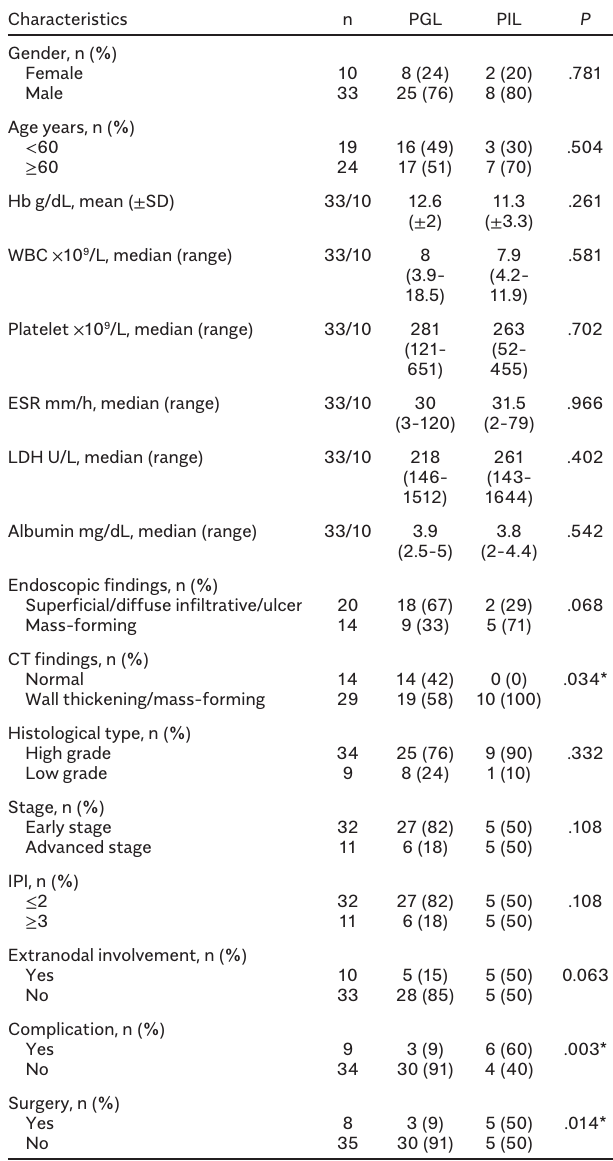
Table 3. Comparison of Primary Lesion Location of Patients with Primary Gastrointestinal Lymphoma